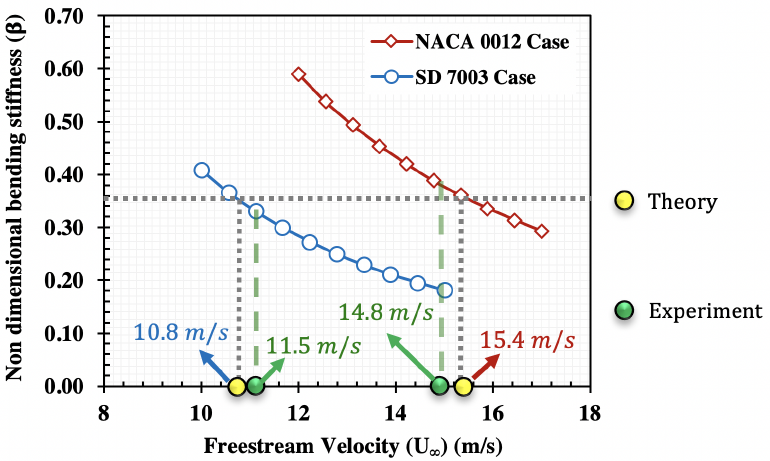
Figure 13. Variation of non-dimensional bending stiffness as a function of freestream